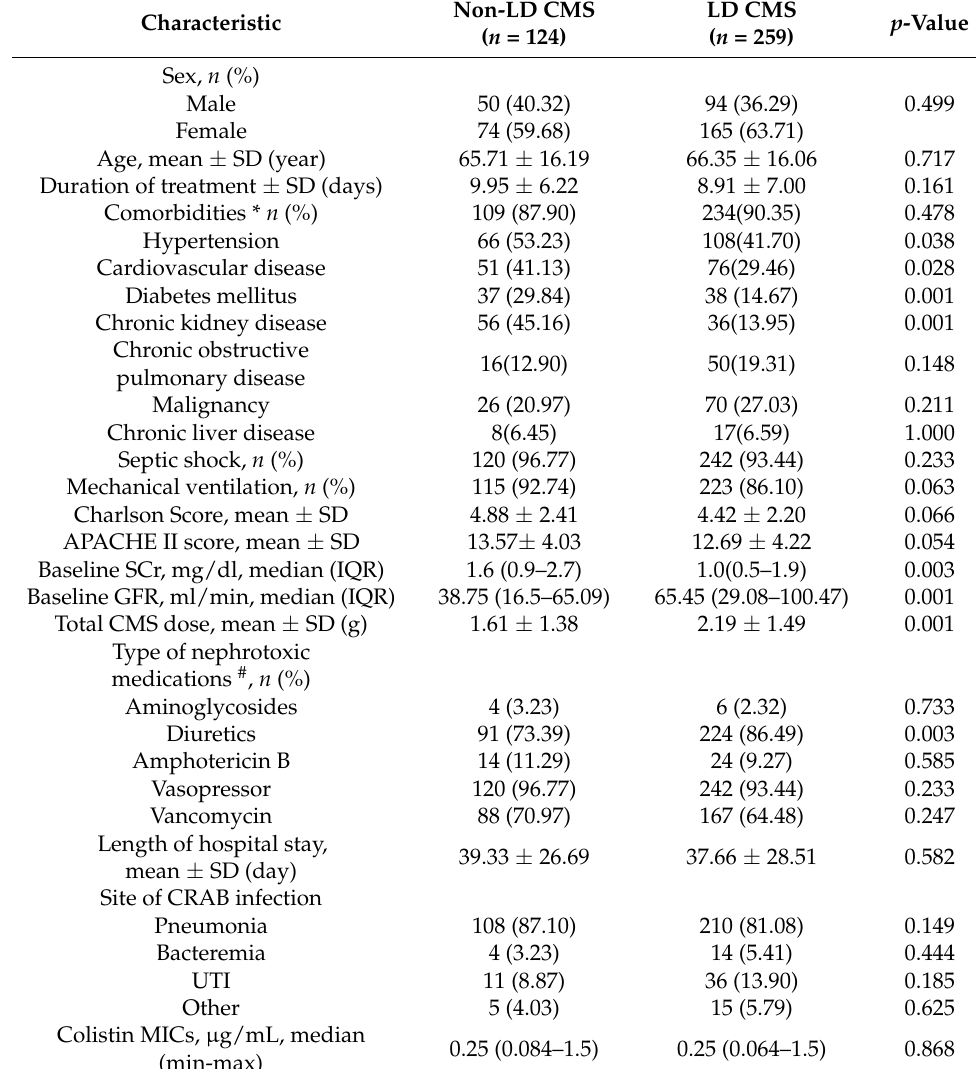
Table 1. Demographic and clinical characteristics of patients received LD CMS compared to non-LD CMS